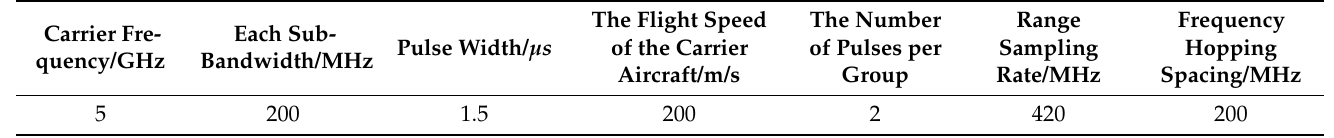
Table 1. Simulation Experiment SFCWSAR system